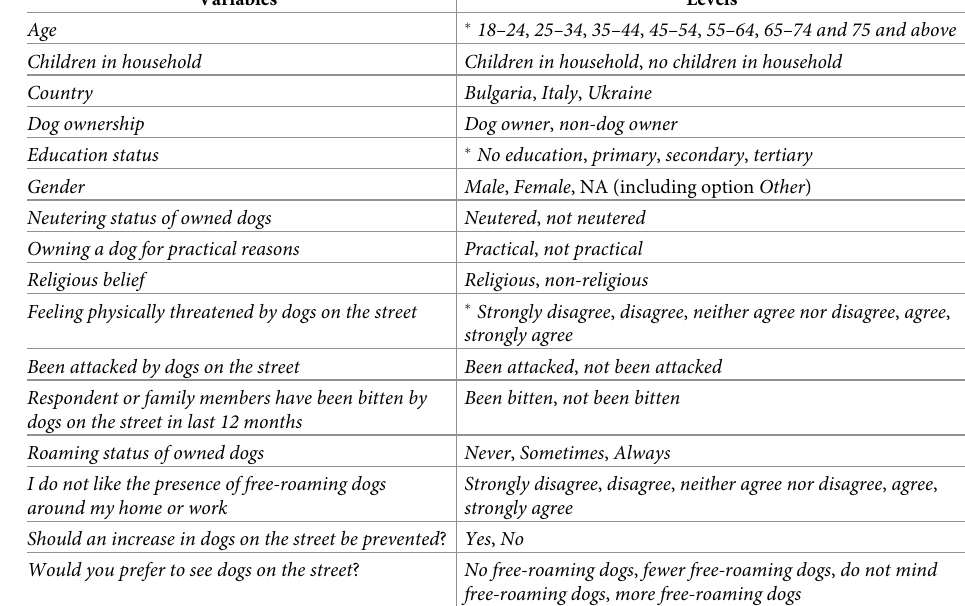
Table 1. Response and predictor variables (self-reported responses to questions) included in the statistical analy- ses and their levels.